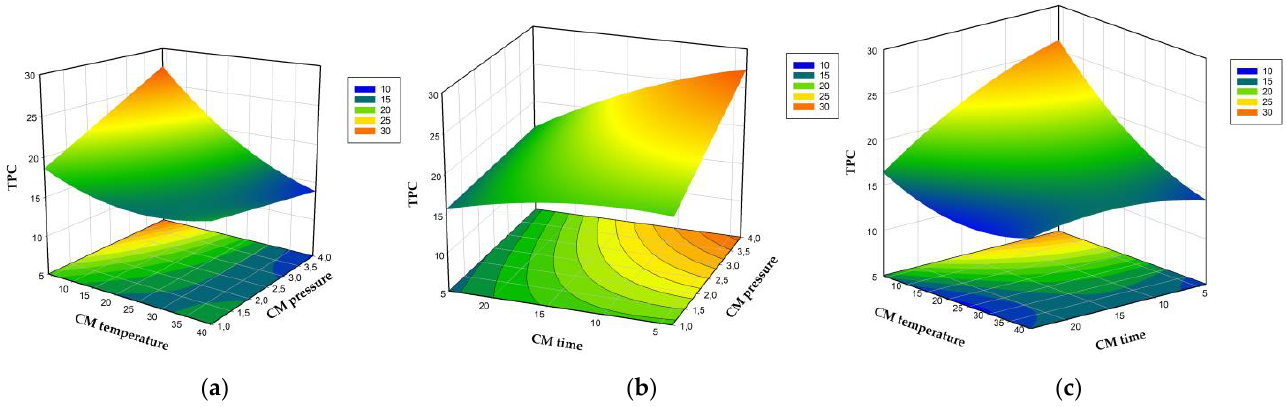
Figure 2. Influence of ( a ) CM temperature (°C) and CM pressure (bar), ( b ) CM time (h) and CM pressure (bar), and ( c ) CM temperature (°C) and CM time (h) on TPC (mg GAE/g DM) of dried strawberries with CM pre-treatment.